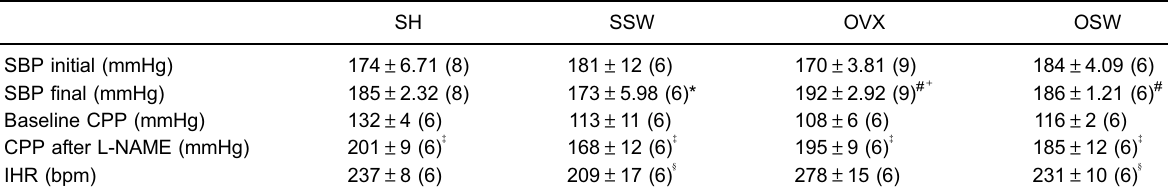
Table 2. Blood pressure, coronary perfusion pressure, and intrinsic heart rate. SH